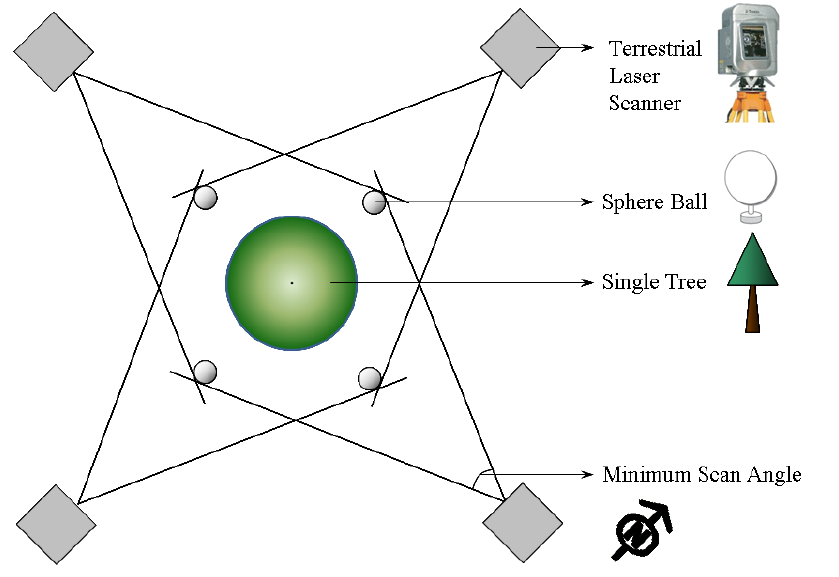
Figure 2. Acquisition of TLS data from four directions for measuring the whole shape of the single target